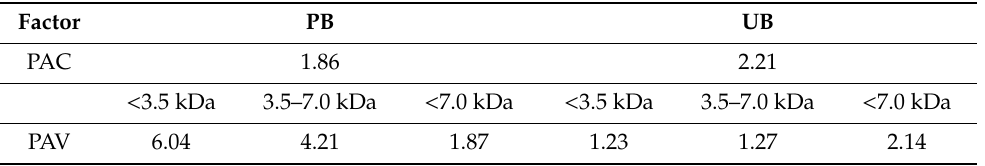
Table 2. Potential bioaccessibility (PAC) and bioavailability (PAV) factors of peptide fractions obtained from PB and